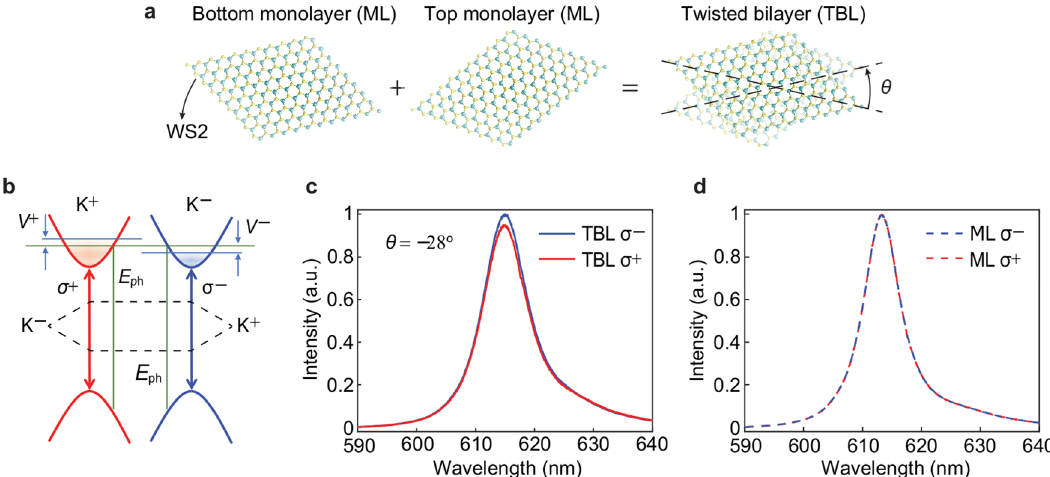
Fig. 2 Excitonic chirality in twisted WS 2 monolayers on an oxidized silicon substrate. a Twisting two WS 2 monolayers with a deterministic angle of θ breaks the parity-inversion symmetry, which leads to a geometrically induced chirality (Fig. 1b), interacting distinctly with left- and right-circularly polarized light (LCP and RCP), in the homostructure. b The handiness of the input light (LCP and RCP) locks with the helicity of the photoluminescence for the two valleys ( σ − and σ + ) at the K-point of the Brillouin zone. The twisting of monolayers equivalently exerts a population difference to the two valleys ( V + and V − ), leading to the intensity difference of the photoluminescence between them. c A twisted bilayer (TB) WS 2 possesses geometrically induced chirality, and hence the luminescence intensity for σ − and σ + excitons are different (solid curves). The top monolayer twists counterclockwise with an angle of 28° leading to a higher luminescence intensity of σ − exciton (solid blue) compared to that of σ + exciton (solid red). The amplitude of the difference in luminescence intensity reaches a value of ~5%. d A linearly polarized light that comprises an equal amount of LCP and RCP shows a vanishing preference on the excitation of the two valleys of σ − and σ + in a monolayer (ML) WS 2 on a SiO 2 /Si substrate at room temperature (dashed curves). Which unambiguously shows we have corrected all system errors that might lead to any discrepancy of the two valleys, verifying the geometrically induced chirality in c .